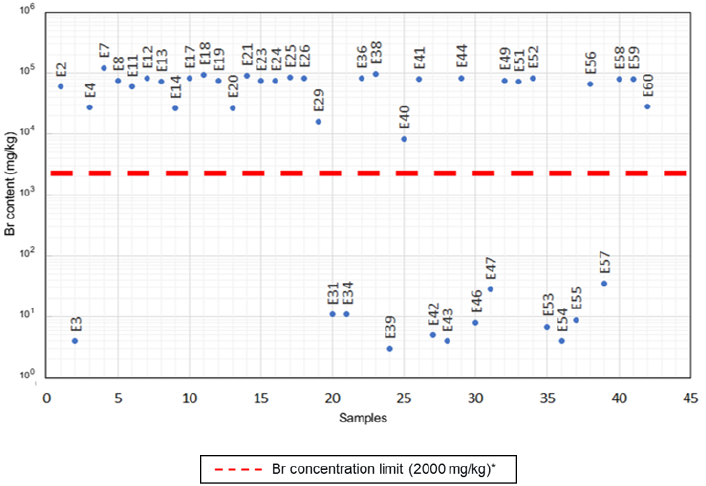
Figure 2. Bromine content measured by XRF of each analyzed sample. (*) Br concentration limit according to CENELEC CLC/TS 50625-3-1 [11].